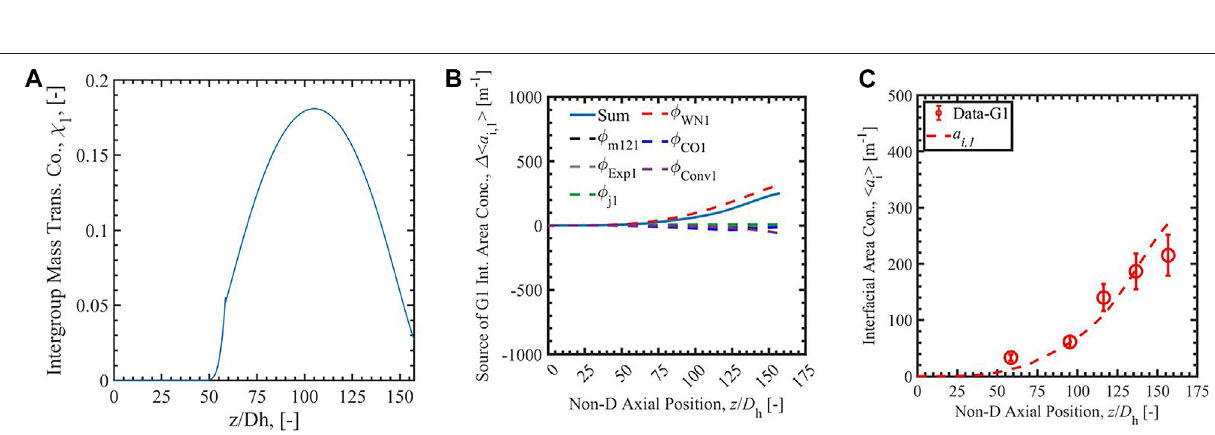
FIGURE 3 | The Run 1 results of group-1 intergroup mass transfer coef fi cient (A) , the source of group-1 interfacial area concentration (B) , and the interfacial area concentration (C) calculated by correlation Sun et al. (2004).